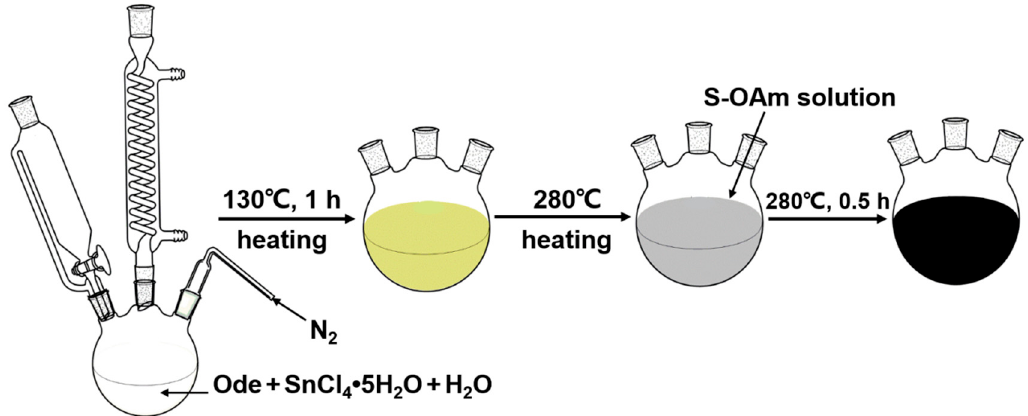
Figure 1. Diagram of the chemical bath synthesis process of SnS nanosheets.